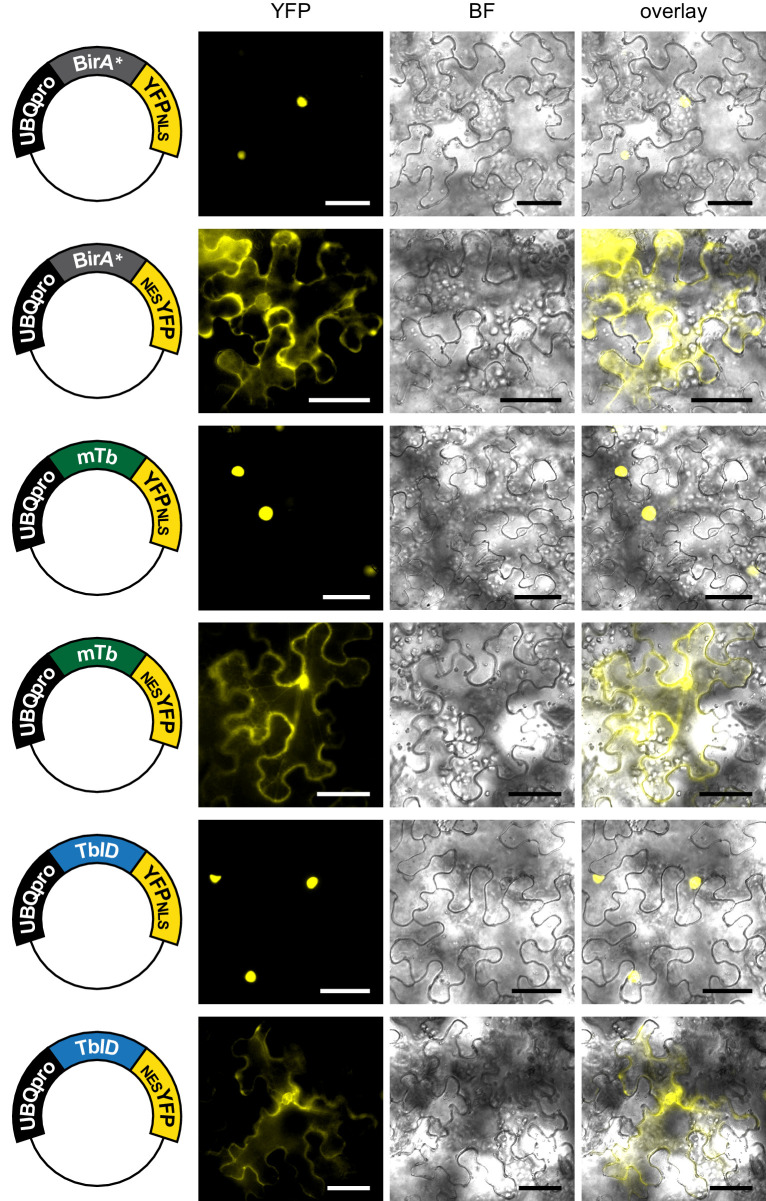
Subcellular localization of biotin ligase constructs in transiently transformed N. benthamiana leaves.Epifluorescence images of N. benthamiana leaves transformed with UBQ10pro::BirA-YFPNLS or UBQ10pro::BirA-NESYFP expression vectors (BirA = BirA*, mTb or TbID) 2 days after transformation. Shown are the YFP and brightfield (BF) channels and an overlay. Scale bar = 50 µm. Constructs are indicated on the left. Nuclear targeted BirA-YFP (NLS) constructs were largely nuclear and cytosol targeted BirA-YFP versions (NES) constructs largely cytosolic.